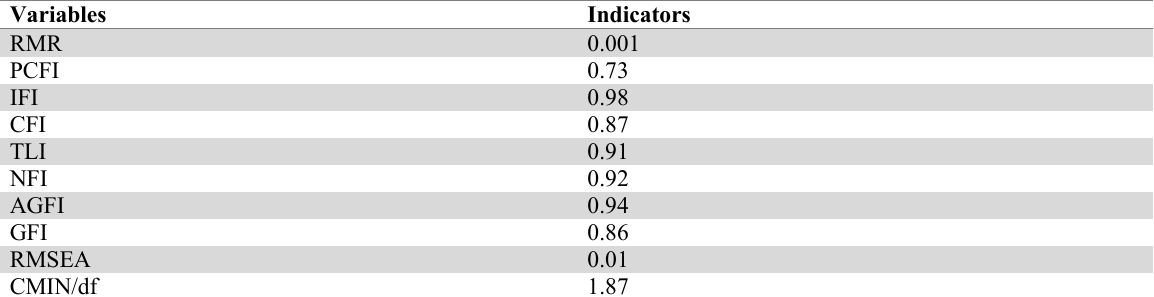
The Model Fitting Indicators